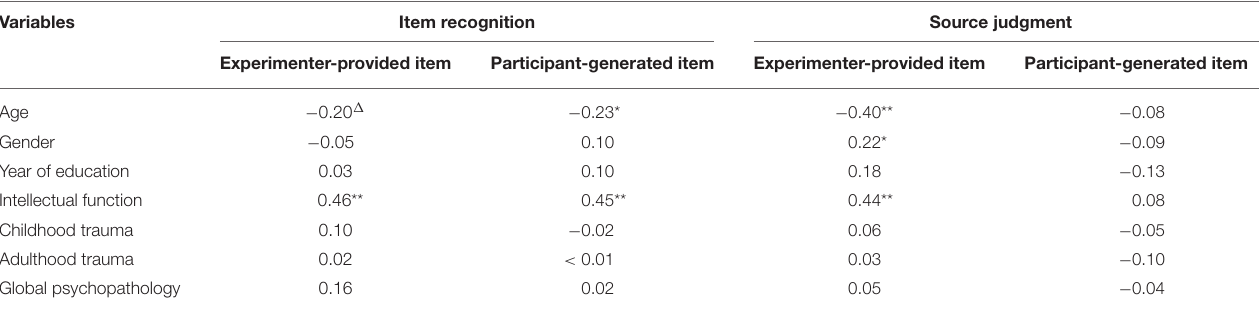
TABLE 2 | Correlation coefficients of self- vs.-other source monitoring performance with demographic variables, global intellectual functions, trauma history, and general psychopathology.